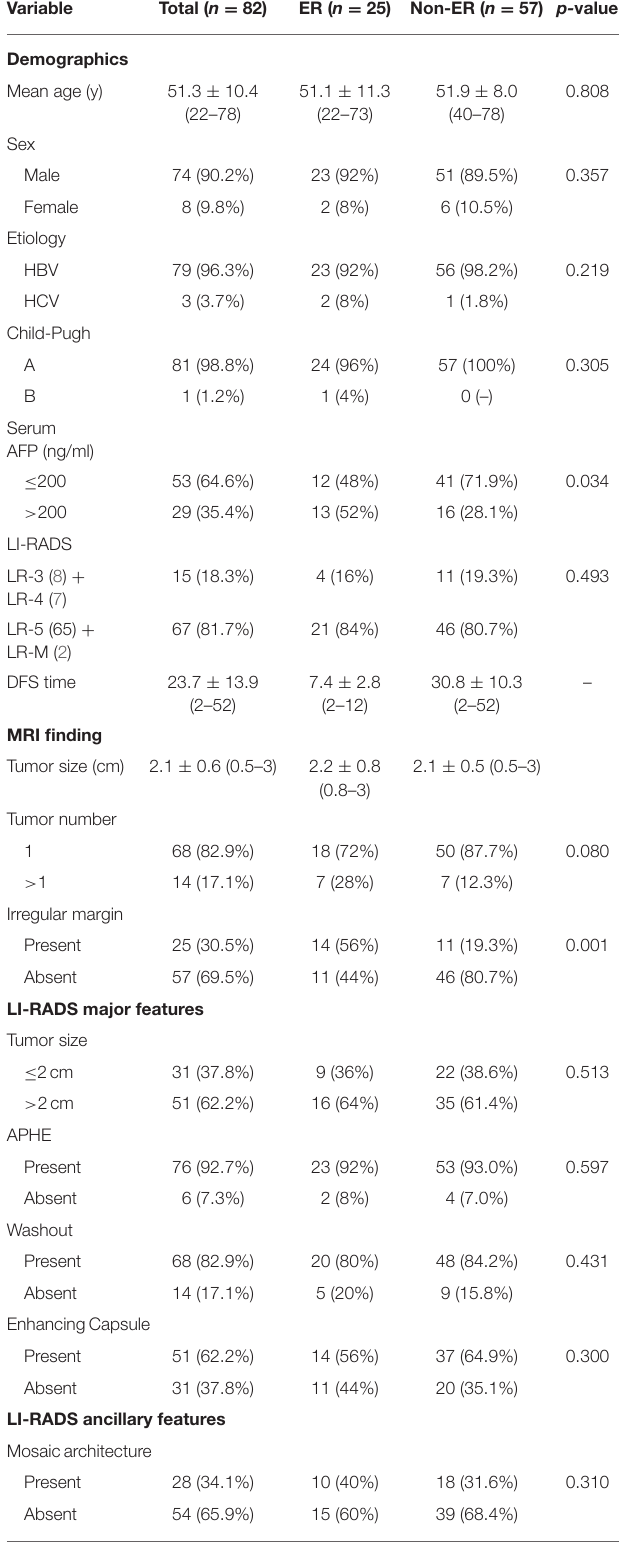
TABLE 1 | Patient characteristics according to